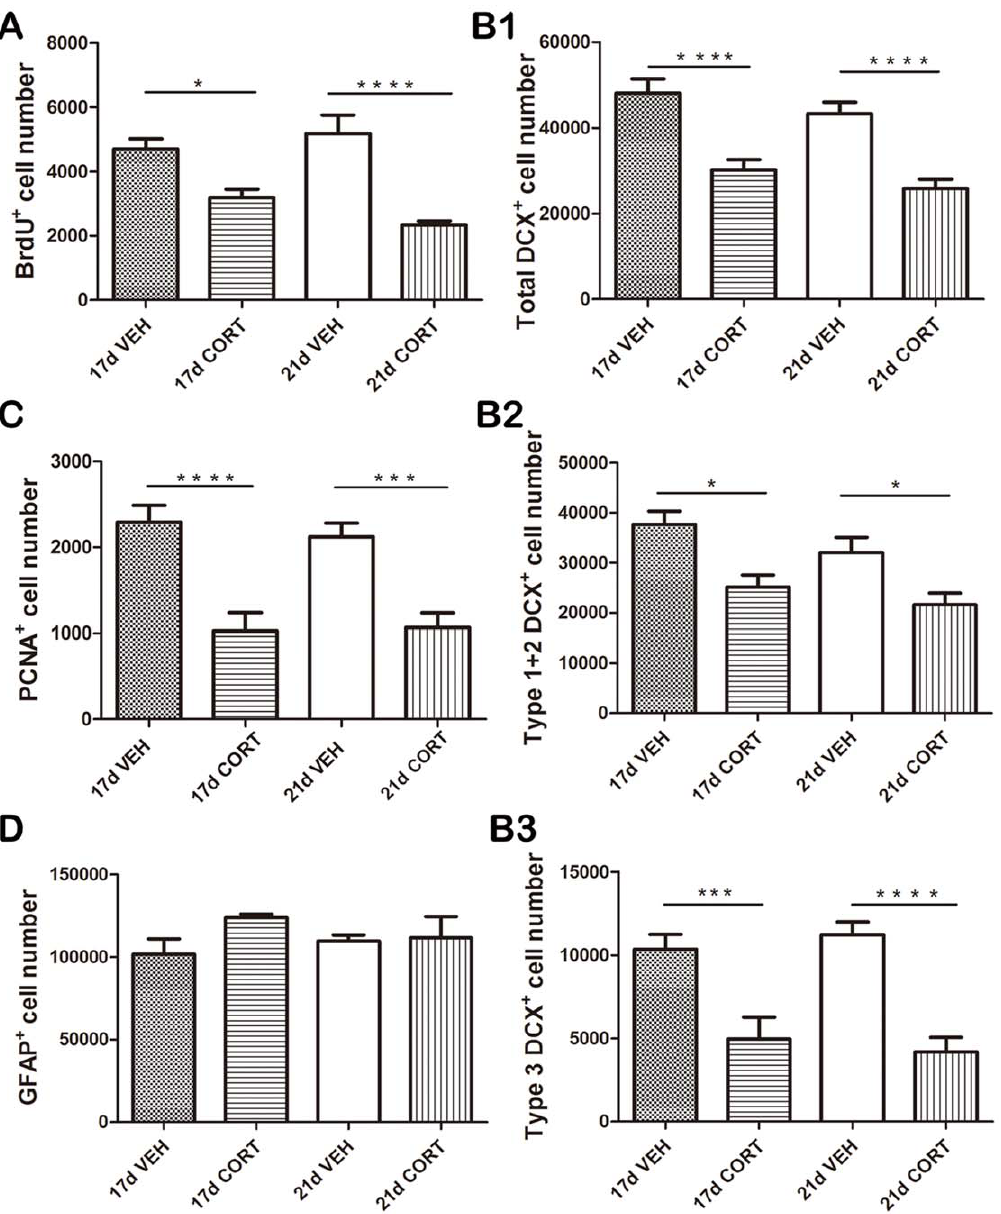
Figure 3. Effects of 17 versus 21 days treatment with corticosterone. A. Both 17 ds (p , 0.05) and 21 ds CORT (p , 0.001) exposure significantly reduced the number of BrdU + cells compared to the respective vehicle control groups. B1. Likewise, both 17 ds and 21 ds CORT exposure significantly (p , 0.001) reduced the total number of DCX + cells compared to the control groups. B2. A significant reduction in immature DCX + cells was found after 17 ds CORT (p , 0.05) as well as after 21 ds CORT exposure (p , 0.05) compared to the respective control groups. B3. The number of mature DCX + cells was significantly reduced after 17 ds CORT (p , 0.005) and after 21 ds CORT exposure (p , 0.001) compared to the respective control groups. C. Both 17 ds and 21 ds CORT exposure groups showed a significant (p , 0.001 and p , 0.005 respectively) reduction in the number of PCNA + cells compared to the corresponding control groups. D. Treatment with corticosterone did not affect the number of GFAP + astrocytes at all (p . 0.05). Data are presented as mean + SEM (n=6 animals per group). For each marker, the groups were first subjected to an ANOVA, followed by a post-hoc Tukey multiple comparison of the means. * p , 0.05; ***p , 0.005; **** p , 0.001.